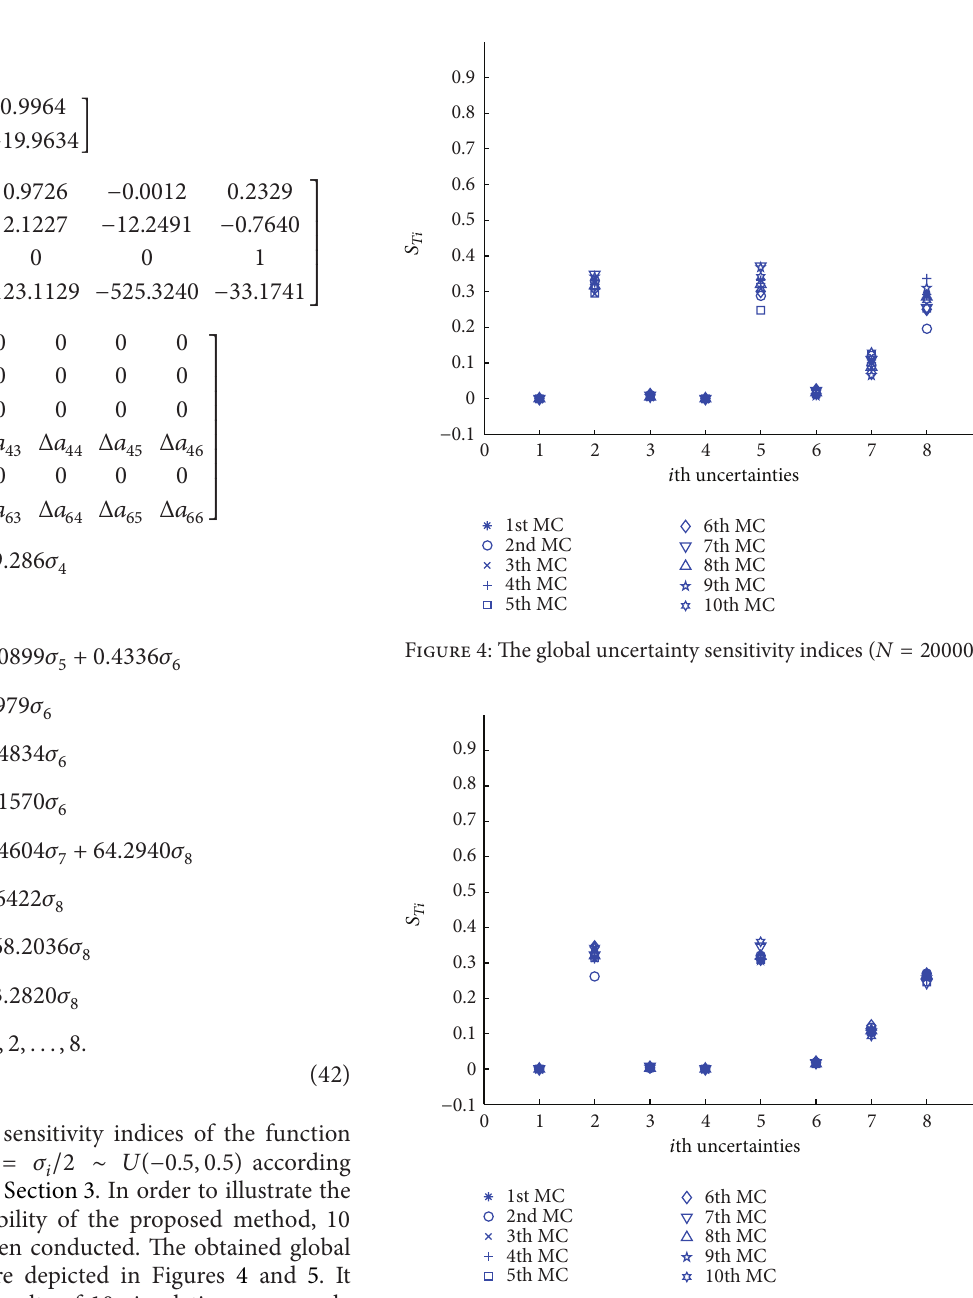
Figure 5: The global uncertainty sensitivity indices ( 𝑁 = 50000